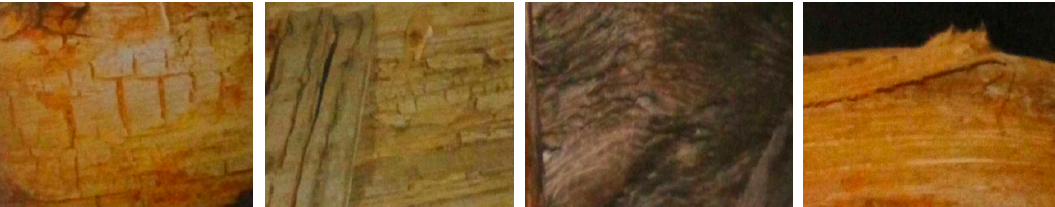
Figure 1. Physical damage from left to right: Lateral crack, fracture, distortion, warpage.